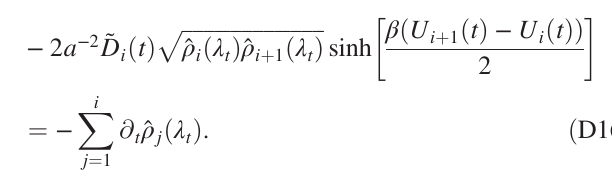
ffiffiffiffiffiffiffiffiffiffiffiffiffiffiffiffiffiffiffiffiffiffiffiffiffiffiffi ρ i þ 1 ð